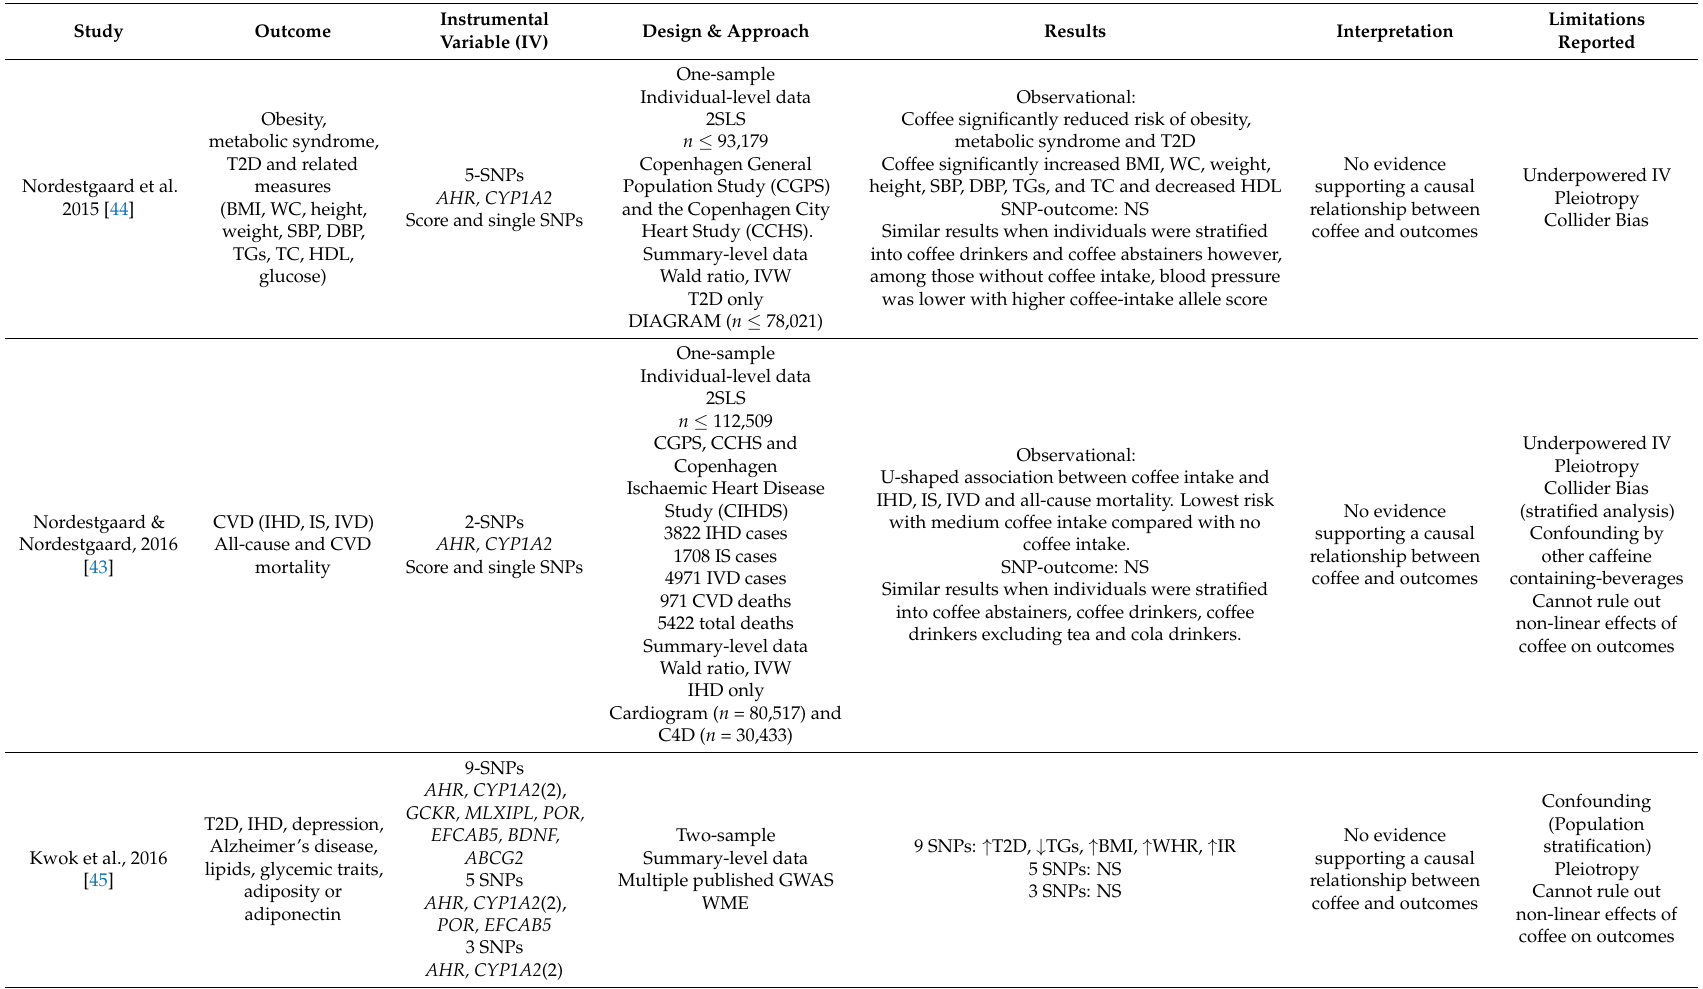
Table 2. Mendelian Randomization (MR) studies of coffee and caffeine